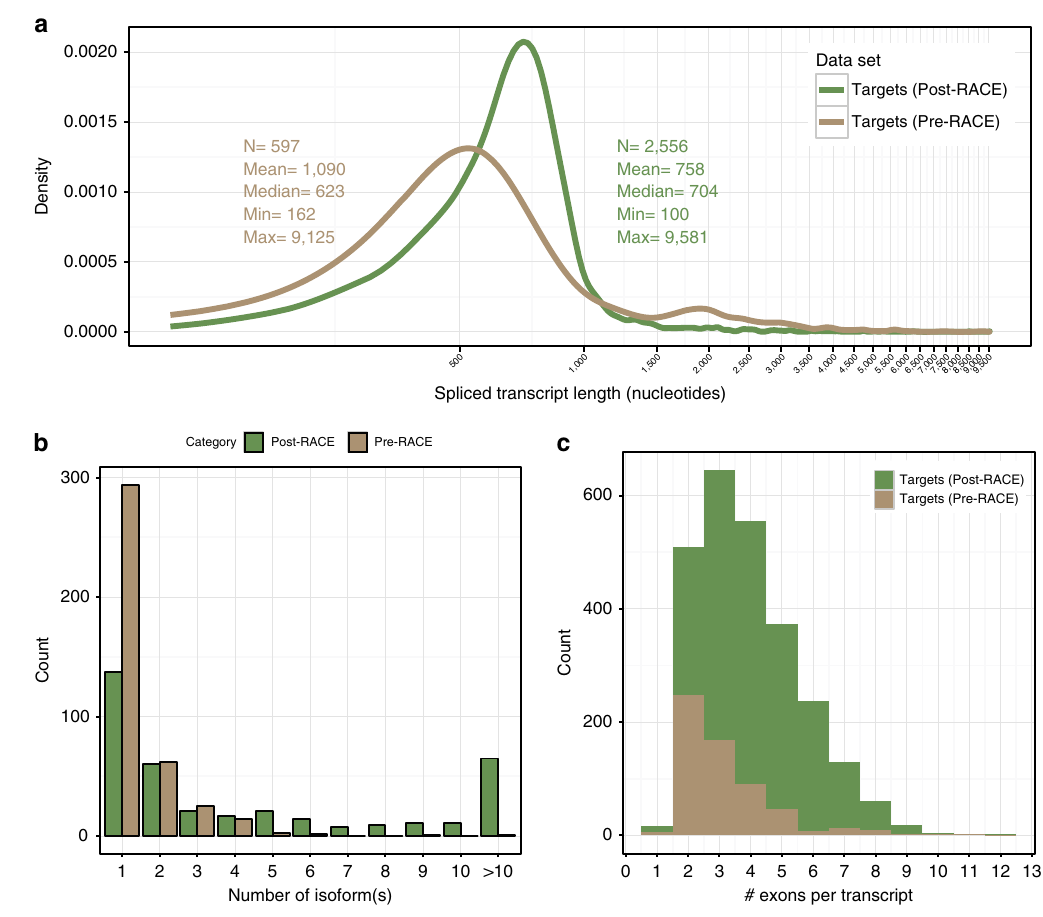
Figure 4 | New isoform discovery and annotation. ( a ) Length distribution of spliced transcripts (logarithmic scale) for pre- (brown) and post-RACE-Seq (green) targets. ( b ) Distribution of the number of alternatively spliced isoforms per pre- (brown) and post-RACE-Seq (green) targeted gene locus. ( c ) Exon count distribution in pre- (brown) and post-RACE-Seq (green) transcripts.